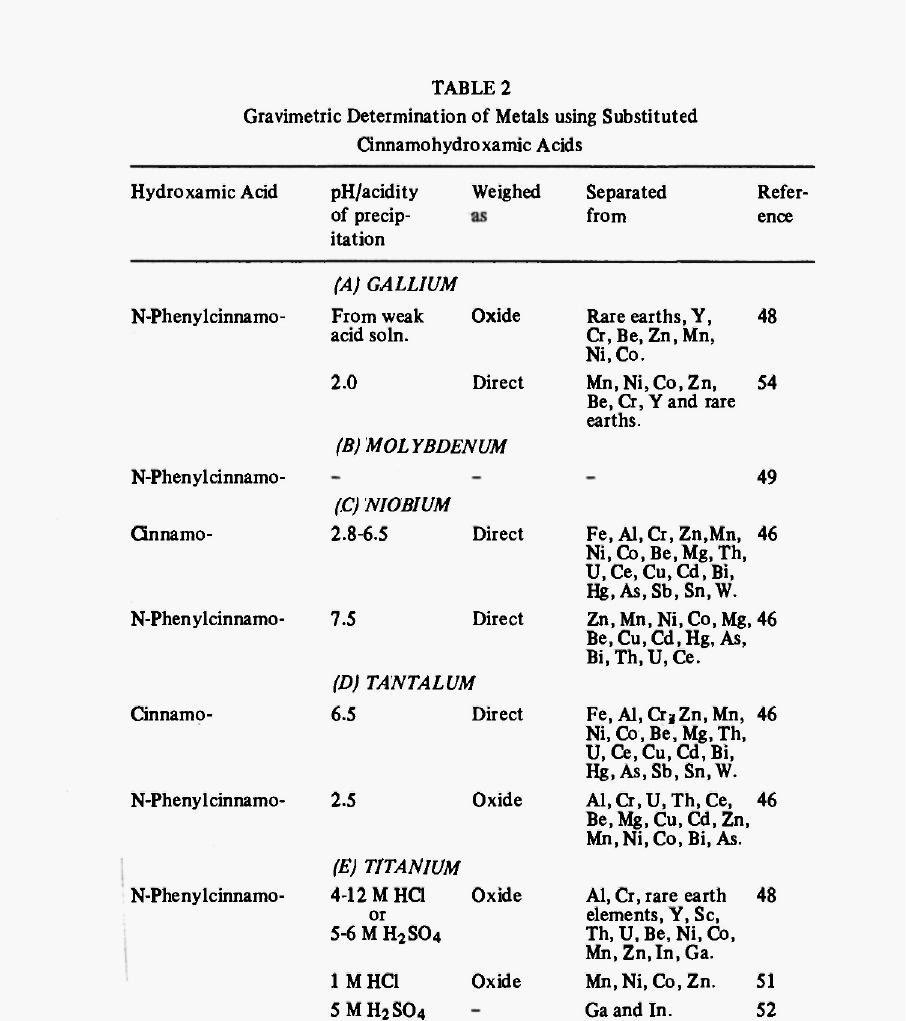
Gravimetrie Determination of Metals using Substituted Gnnamohydroxamic